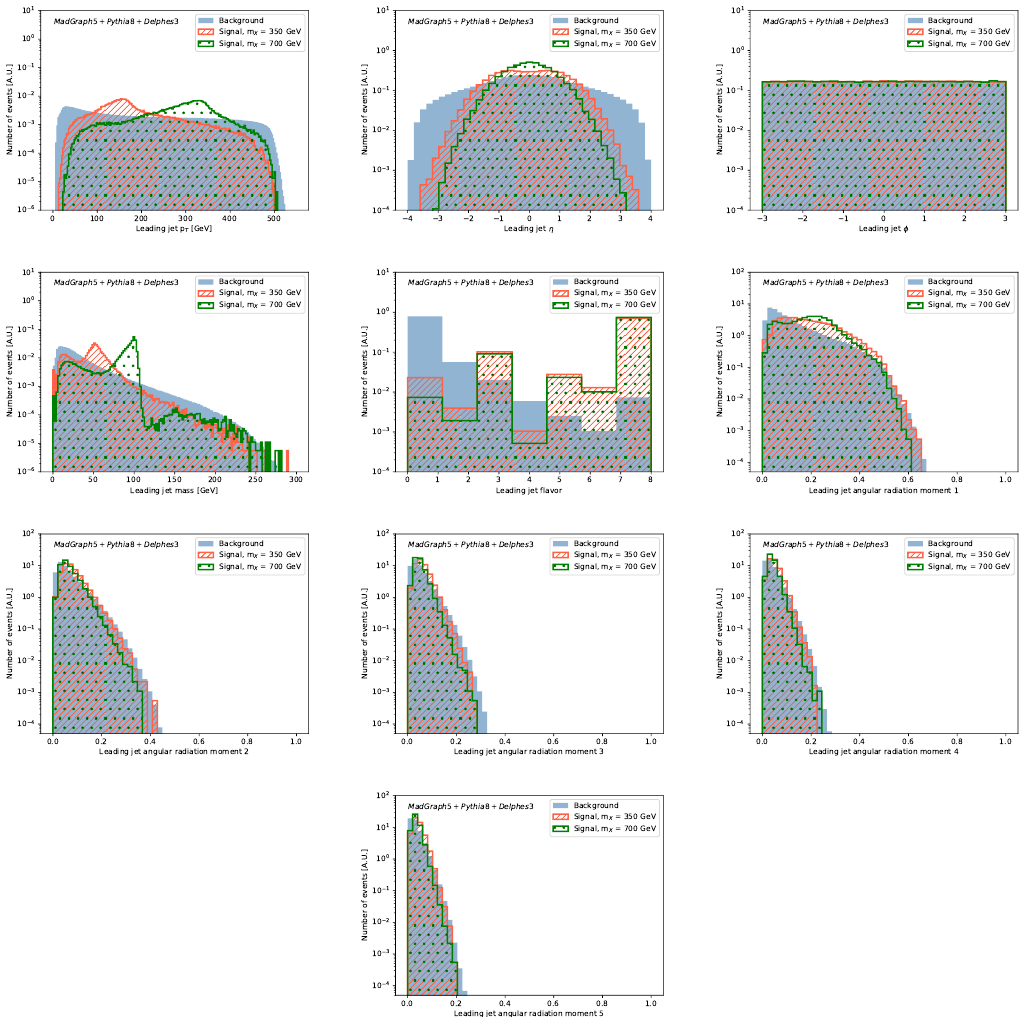
Figure 11. Leading jet input PFN